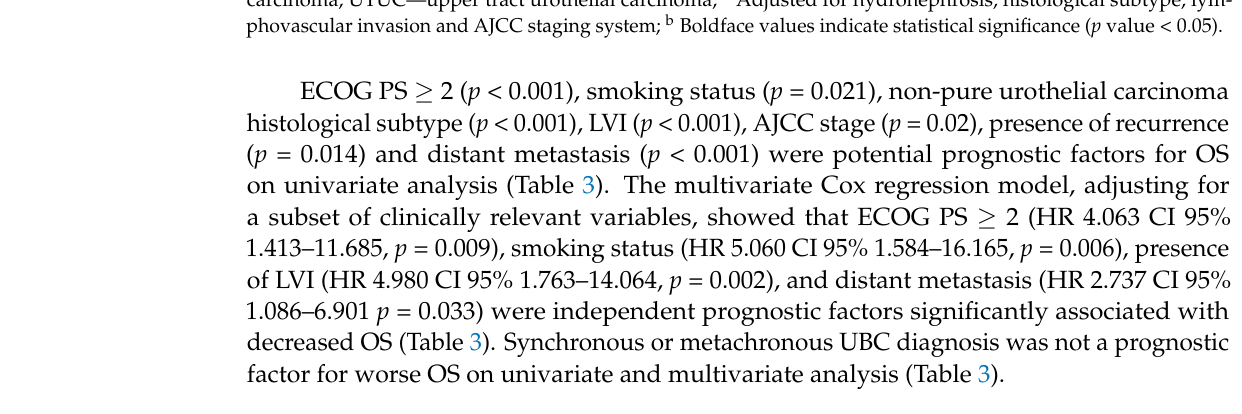
Table 3. Univariate and multivariate Cox regression analysis of prognostic factors for